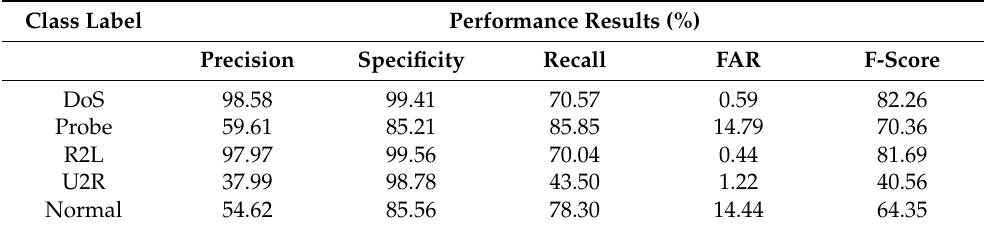
Table 7. Standard LSTM performance on NSL-KDDTest − 21 using all 41 features.